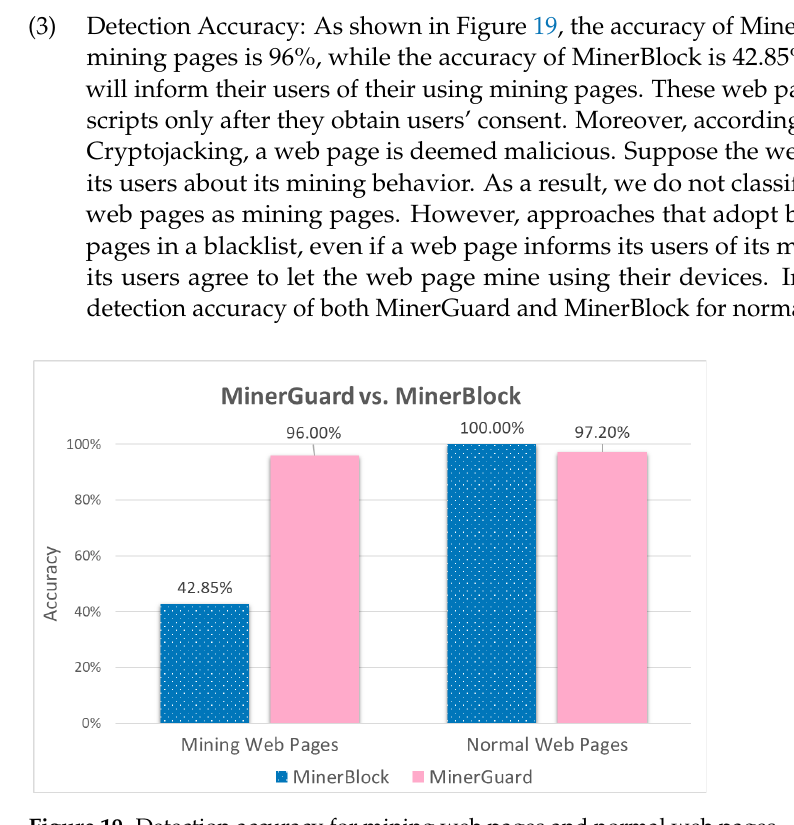
Figure 18. Resource usage overhead for handling mining web pages.